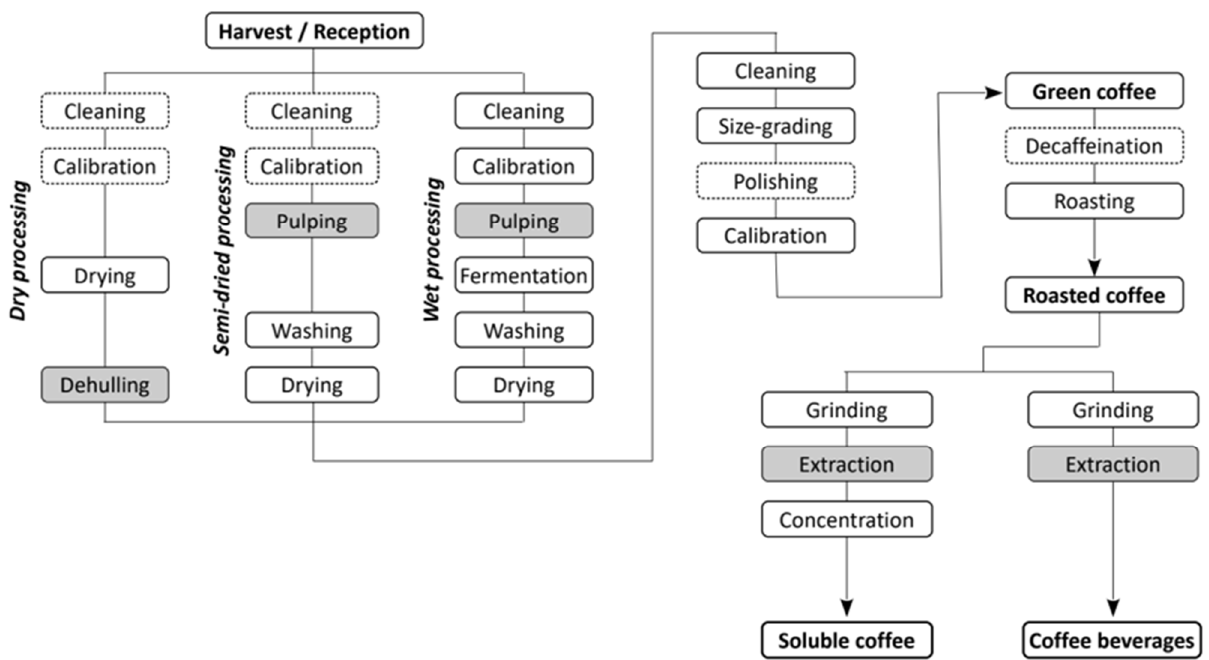
Figure 2. The life cycle of coffee products and residue generation steps. Grey boxes indicate major steps of coffee solid residue production. Own compilation based on literature data [35].